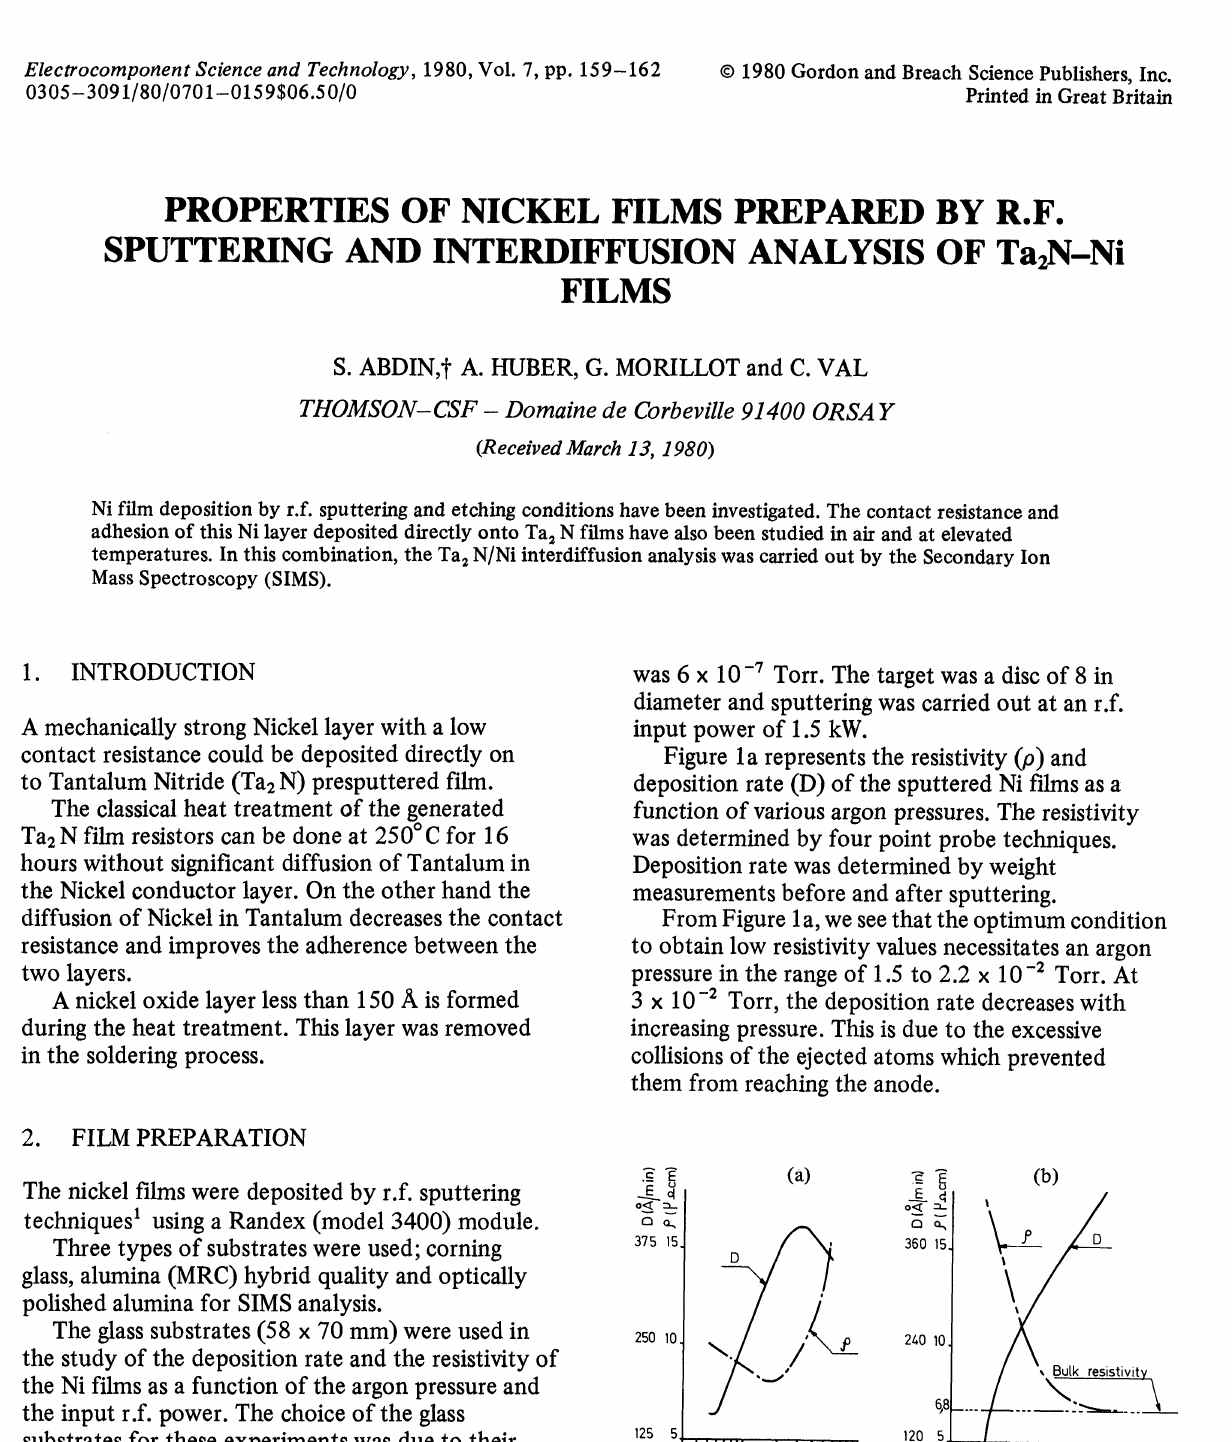
(a) Resistivity and deposition rate vs. argon pressure. (b) The dependance of resistivity and deposition rate on the r.f. input